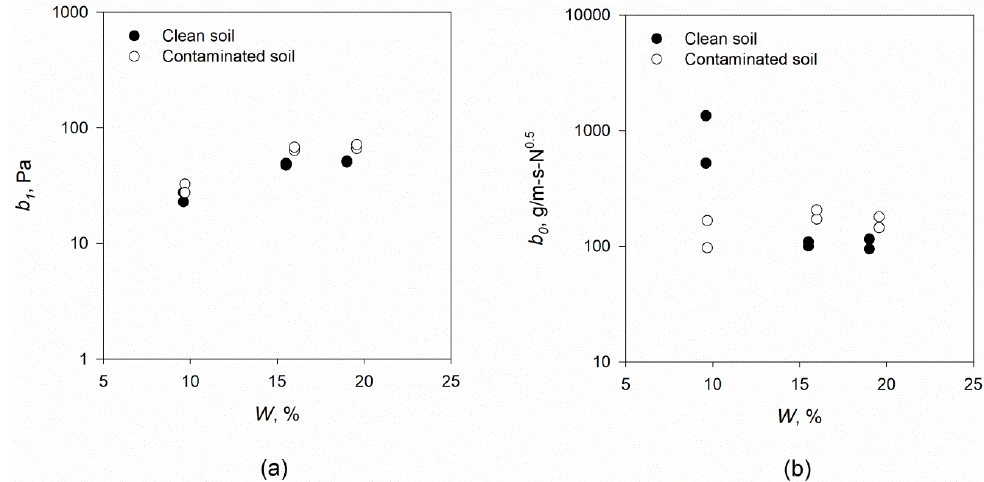
Figure 5. Derived b 1 and b 0 from the “mini” JET device for small scale at three different soil moisture contents for clean and crude oil contaminated soils: ( a ) parameter b 1 and ( b ) parameter b 0 .